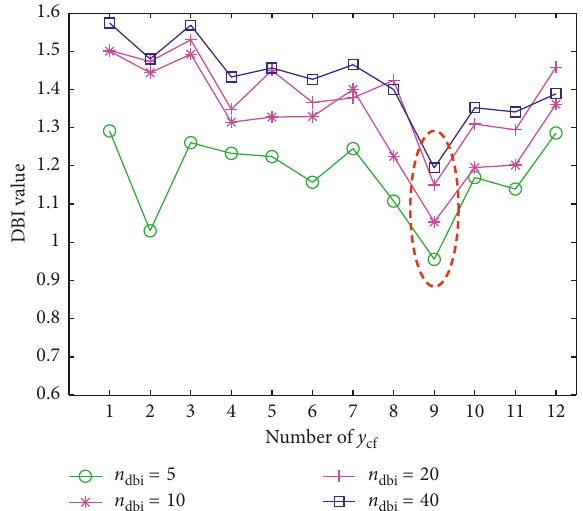
Figure 5: Experiment I: the DBI values for R � 0 y R 􏼂 􏼃 y cf